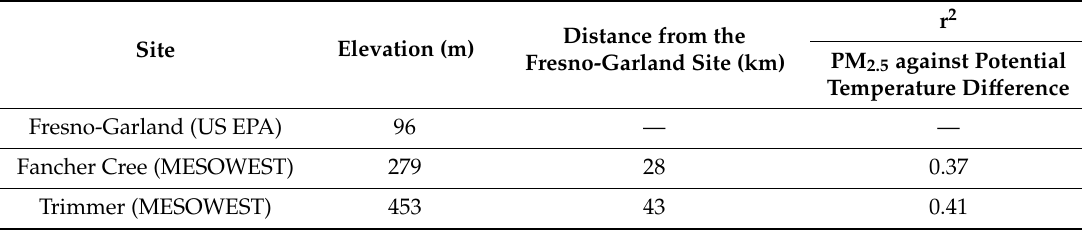
Table 4. Summary of the relationship strength between PM 2.5 and potential temperature gradients for di ff erent sites in